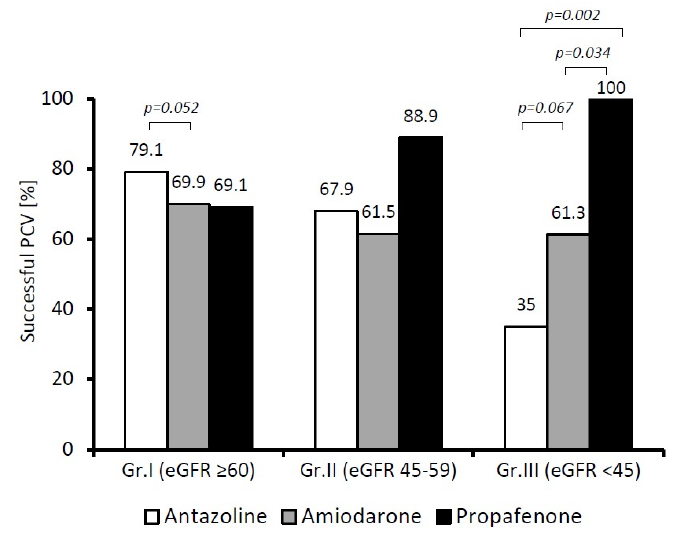
Figure 3. Comparison of pharmacological effectiveness (PCV) of the drugs at different stages of chronic kidney disease (patients: Group I n = 531; Group II n = 149; Group III n = 97).